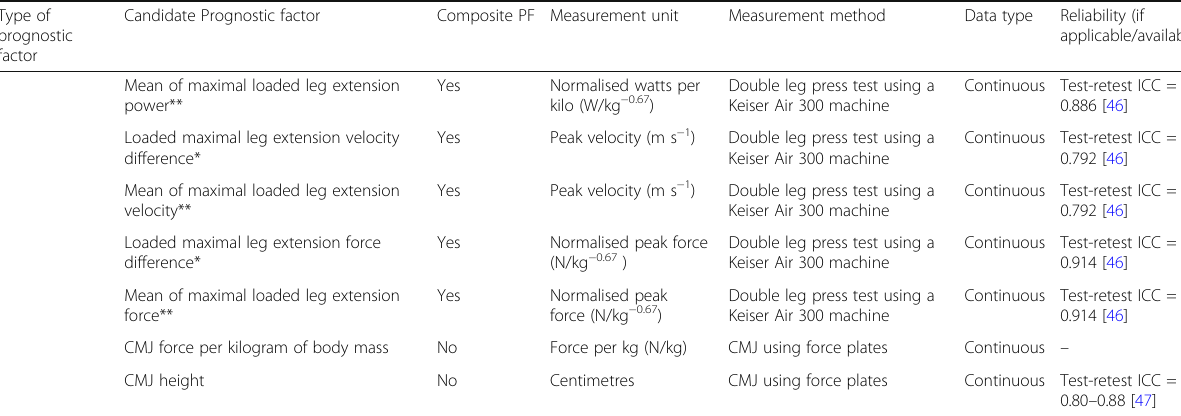
Table 5 Candidate prognostic factors — exploration (Continued) Type of Candidate Prognostic factor Composite PF Measurement unit Measurement method Data prognostic factor